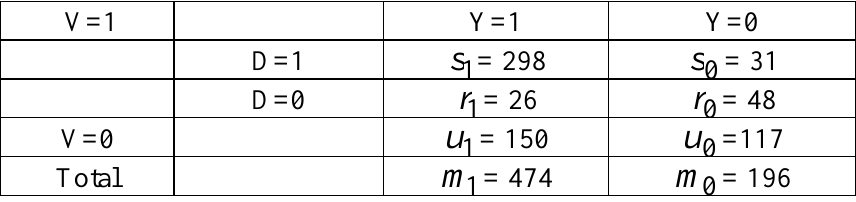
Table 13. Hepatic scintigraphy study for verification